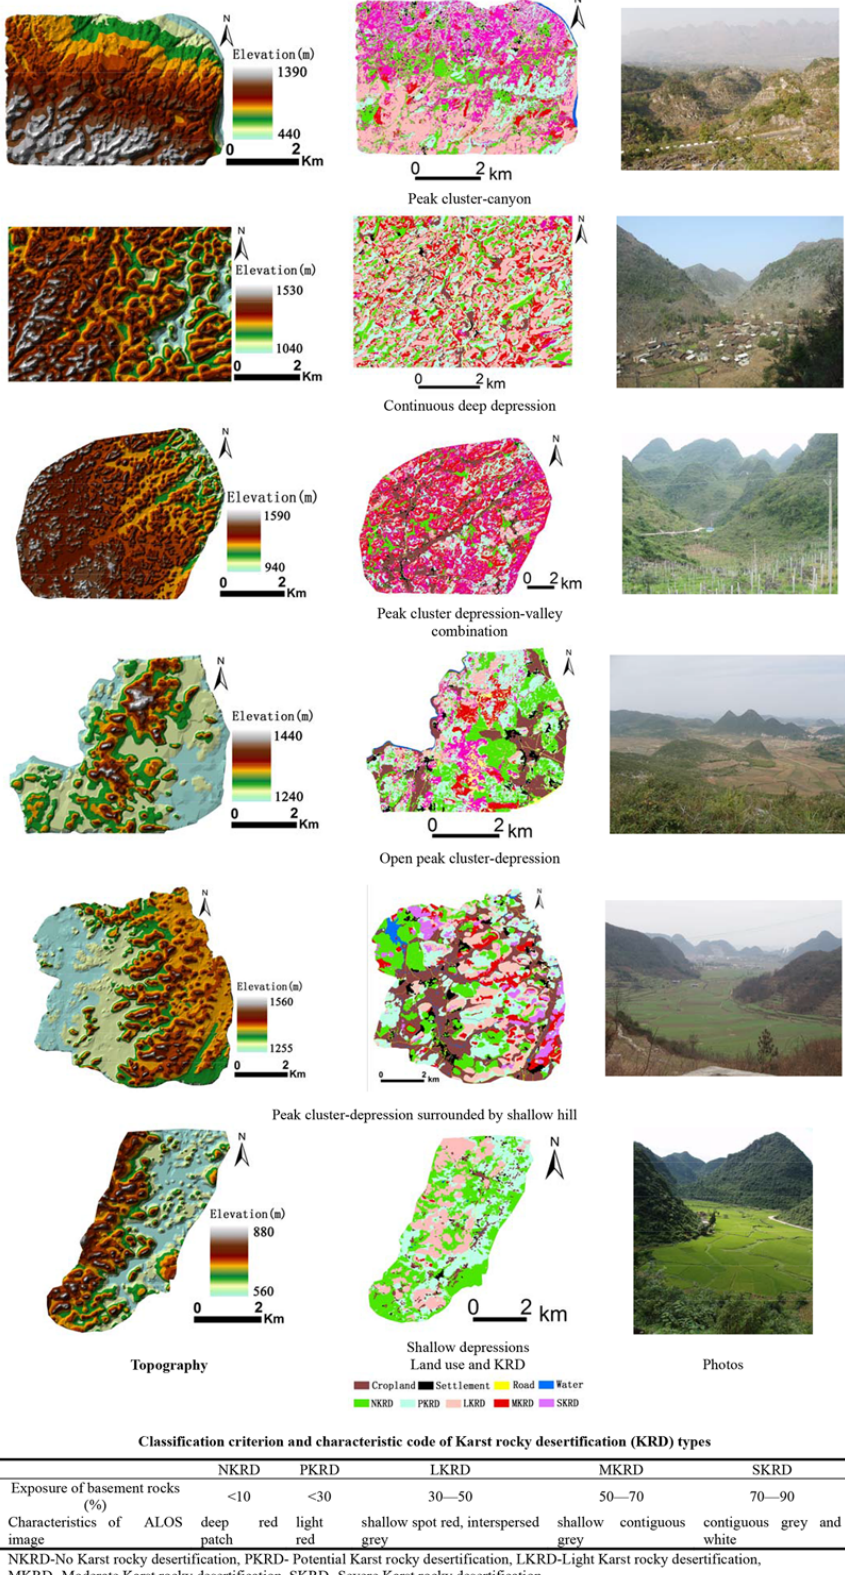
Figure 2. The digital topography, land use and KRD of the study areas. Solid Earth, 7, 741–750, 2016